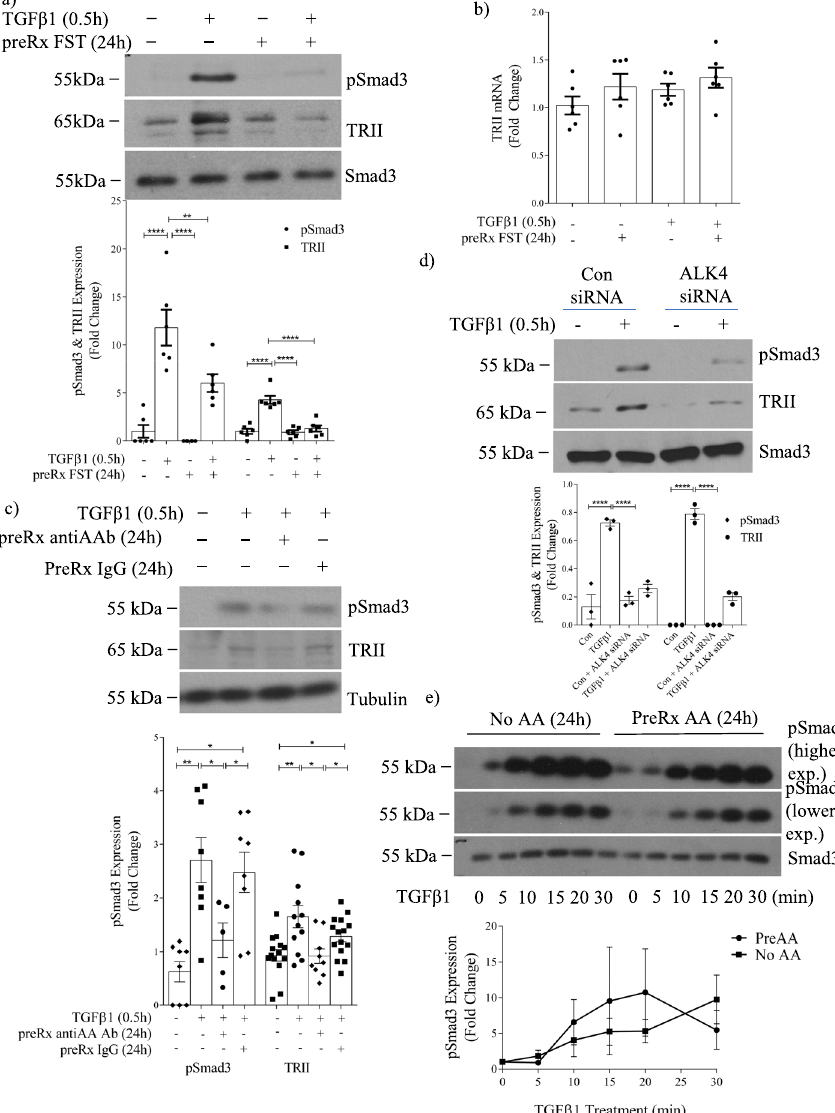
Fig. 4 Activin A facilitates TGFβ1-induced type II receptor expression without altering TGFβ1 receptor sensitivity in MC. a TGFβ1 for 30 min increased TRII expression and Smad3 activation in whole cell lysate, and both were prevented by 24 h pretreatment with follistatin (n transcript after 24 h of follistatin with or without TGFβ1 for 30 min. c Pretreatment with an actA neutralizing antibody for 24 h inhibited acute (30 min) TGFβ1-induced Smad3 activation and TRII upregulation (n These were similarly inhibited by downregulation of the actA type I receptor ALK4 with siRNA ( d ) (n Pretreatment with actA (20 ng/ml) for 24 h did not affect acute TGFβ1-induced Smad3 activation (n **** P < 0.05, 0.01, 0.0001; one-way ANOVA with Tukey’s multiple comparisons post hoc